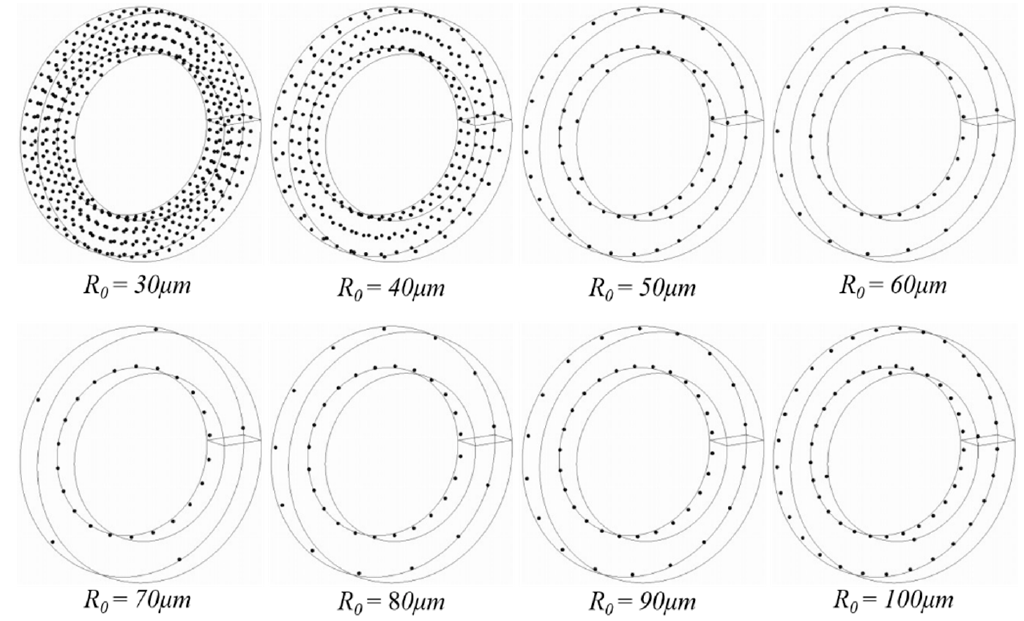
Figure 18. Domain for nuclei distribution in the flow field: ( a ) iso-metric view; ( b ) front-view